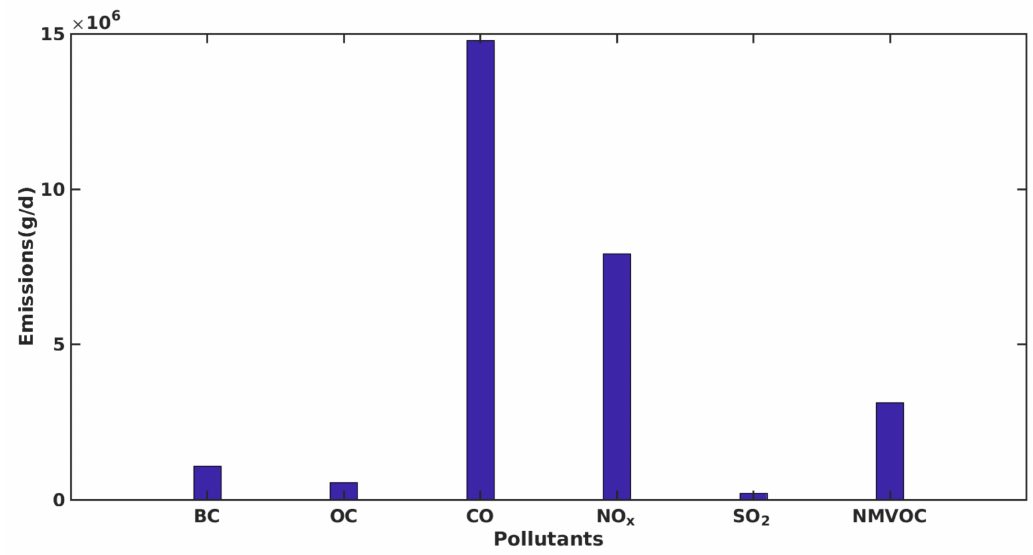
Figure 4. Total traffic emissions in Yopougon of BC, OC, CO, NO x , SO 2 and